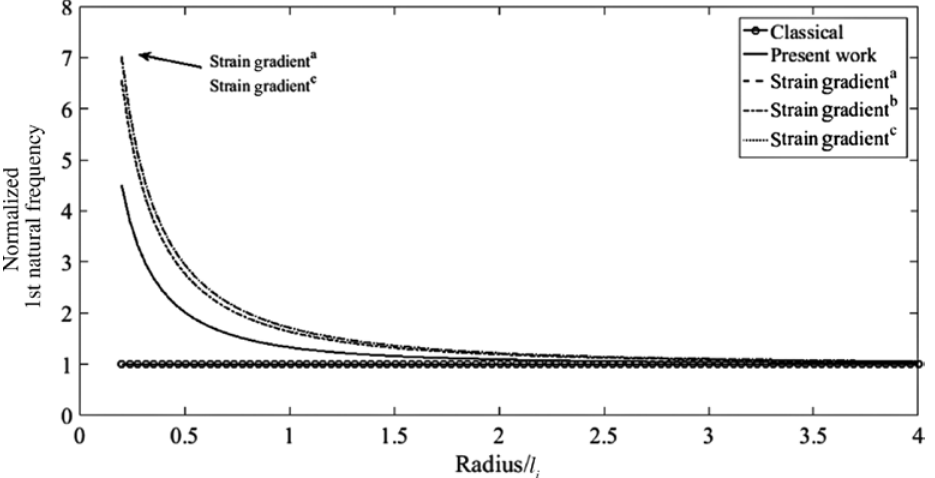
is the static length scale in i